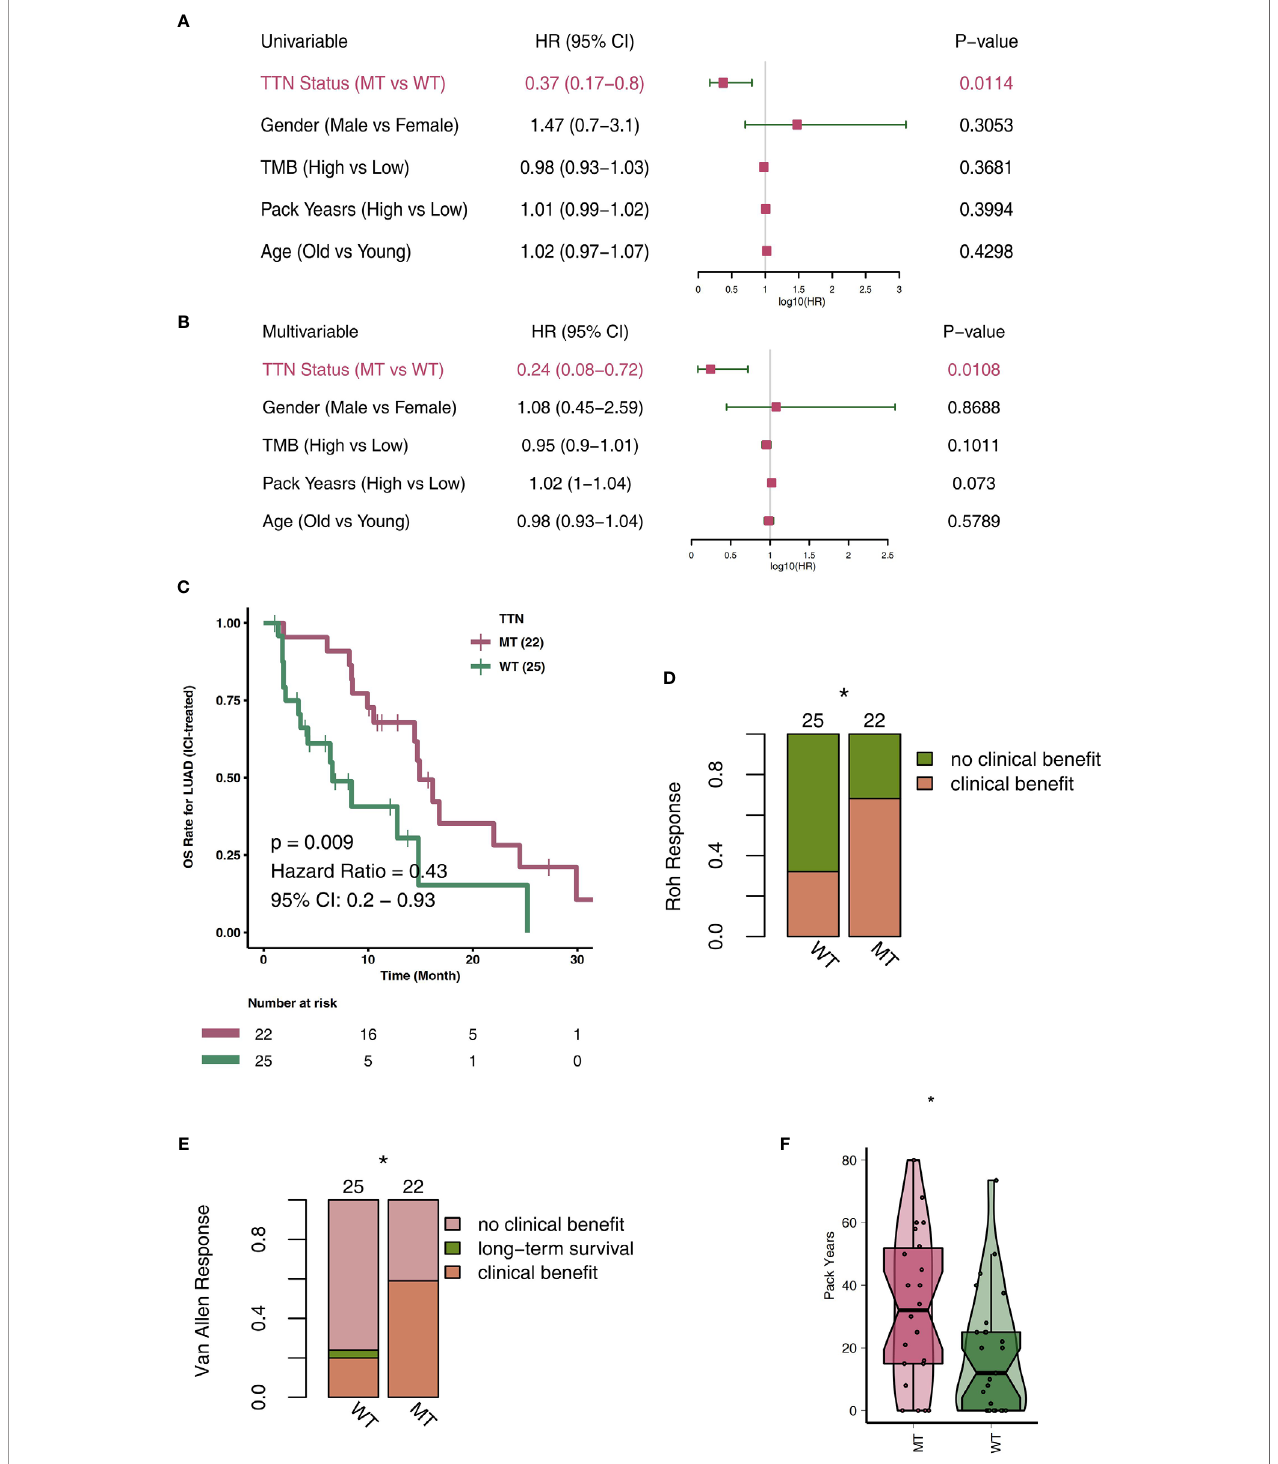
FIGURE 1 | TTN-MT was associated with prolonged OS in LUADpatients responding to treatment with ICIs. UnivariableCox regression analysis (A) andmultivariableCox regression analysis insubgroups of TTN status, age, sex, TMB status, and pack yearsin the ICI cohort (B) . (C) Kaplan-Meier curves comparingthe overallsurvival (OS)of patients with TTN-MTand patients with TTN-WT inthe ICI-cohort. (D) TTN-MTwas associated with clinical bene fi t (Roh response). (E) TTN-MTwas associatedwith clinical bene fi t (Van Allen). (F) TTN-MTwas associatedwith longer packyears. *P <